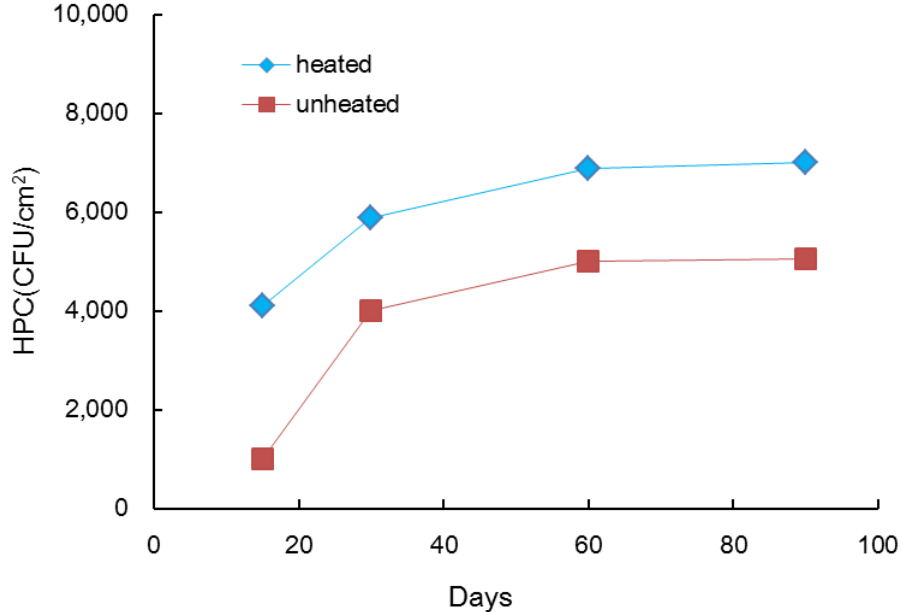
Figure 2. Biofilm accumulation, as assessed with HPC on PEX pipes in contact with heated and non-heated tap